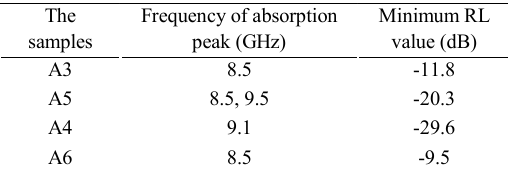
Table 2. Microwave absorption properties of the samples with different CB mass ratios.